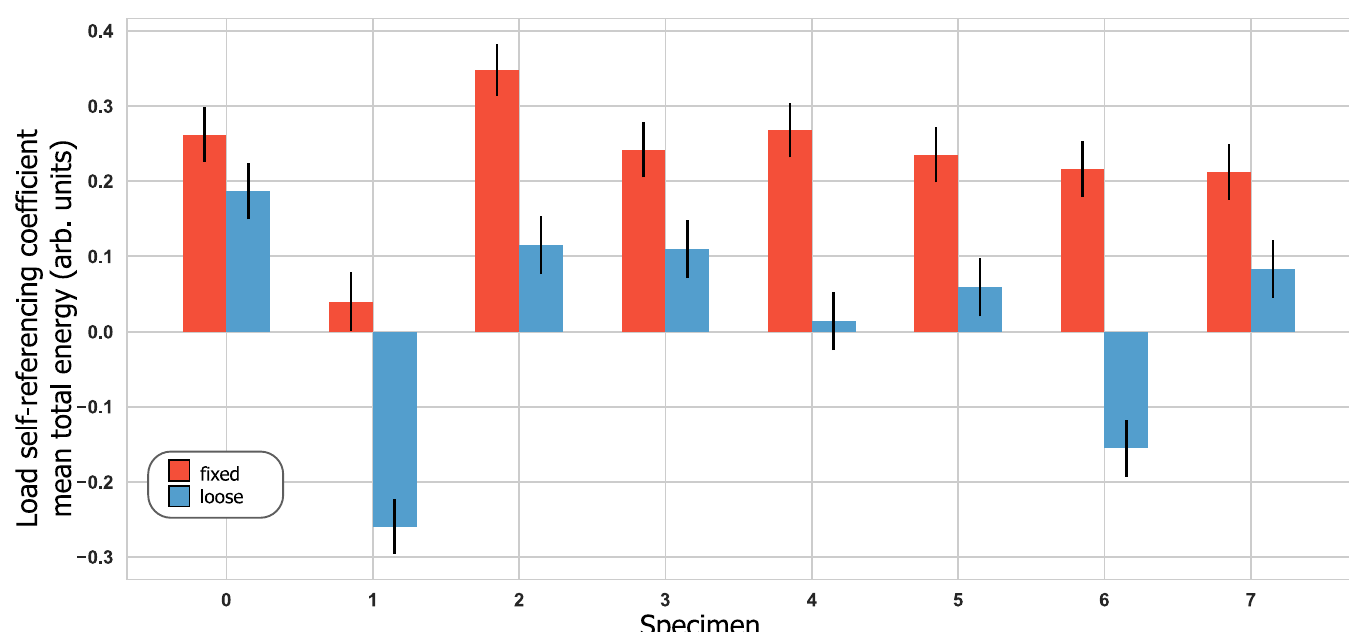
Fig 8. Load self-referencing coefficient for the mean total signal energy in the implant sensor with error bars depicting the estimated uncertainty. The corresponding ROC-AUC was 0.92.